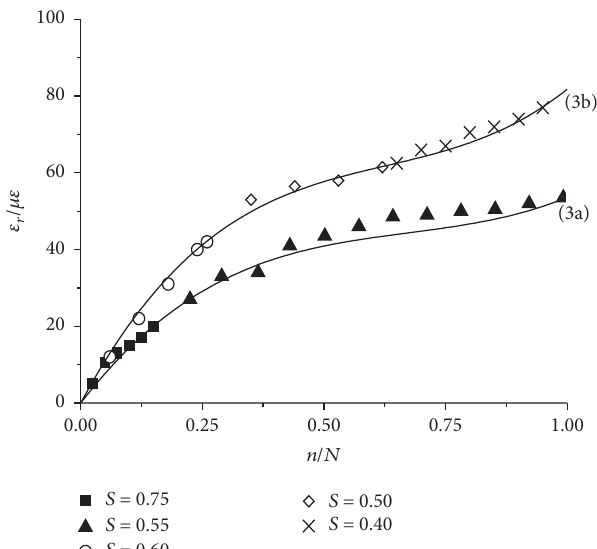
Figure 5: Relationship of residual strain and relative fatigue cycle in T-C-C variable amplitude loading.